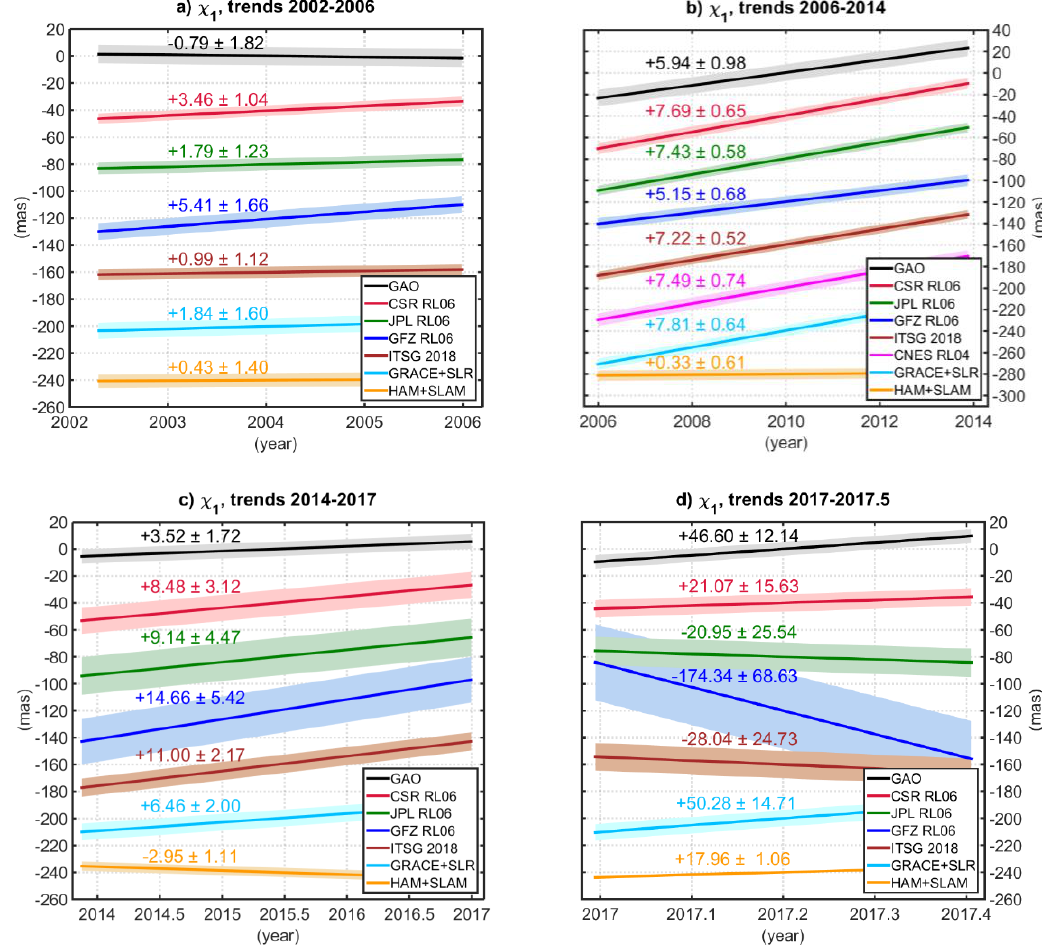
Figure 4. Trends in χ 1 component of GAO, GSMAM, GRACE + SLR, and HAM + SLAM together with their errors for four time periods: ( a ) 2002–2006, ( b ) 2006–2014, ( c ) 2014–2017, ( d ) 2017–2017.5. The values are given in mas / year. The shades show the errors of trends determined. Note that CNES RL04 data covered only the period 2006–2014 in full and was not included in (a), (c) and (d).